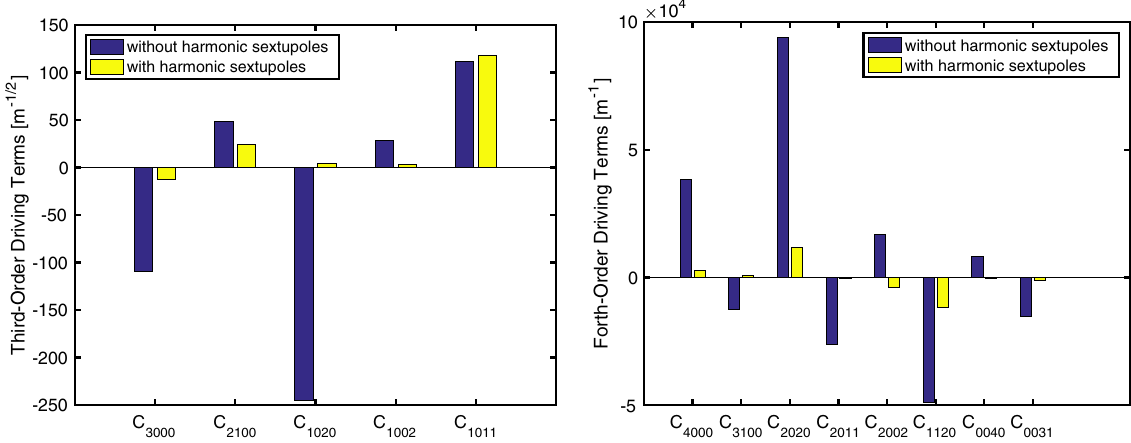
FIG. 12. Harmonic sextupole scanning of the dynamic aperture in the normalized coordinates in tracking (left) and the statistically estimated aperture a 3 based on the third-order resonance driving terms (right).